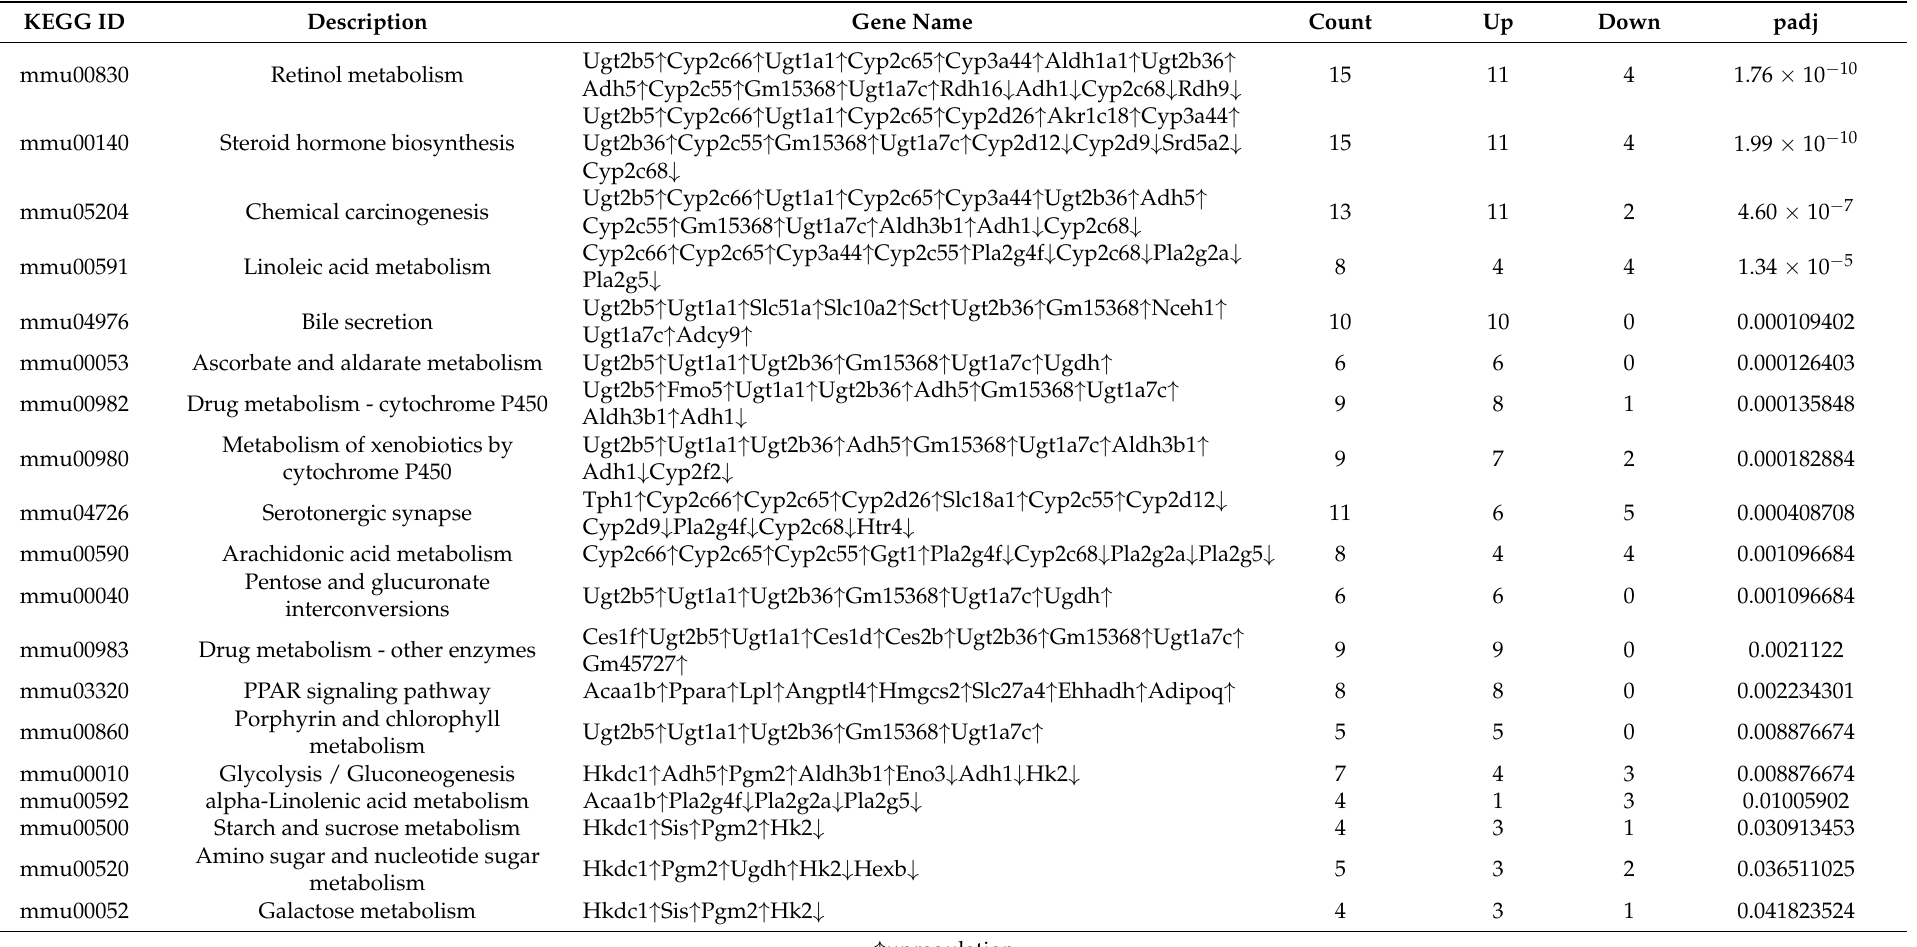
Table 5. List of pathways enriched with colonic DEGs (padj <